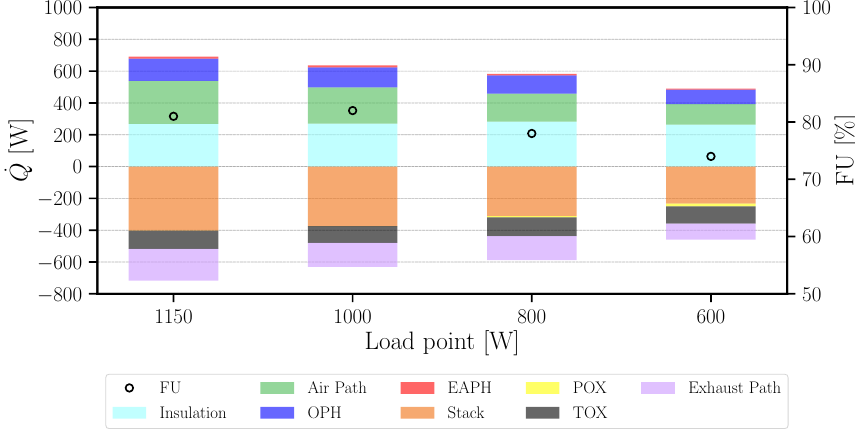
Figure 19. Heat flow of the hotbox components and relevant piping at different load points, hotbox temperature and fuel utilization of the stack (all based on simulation